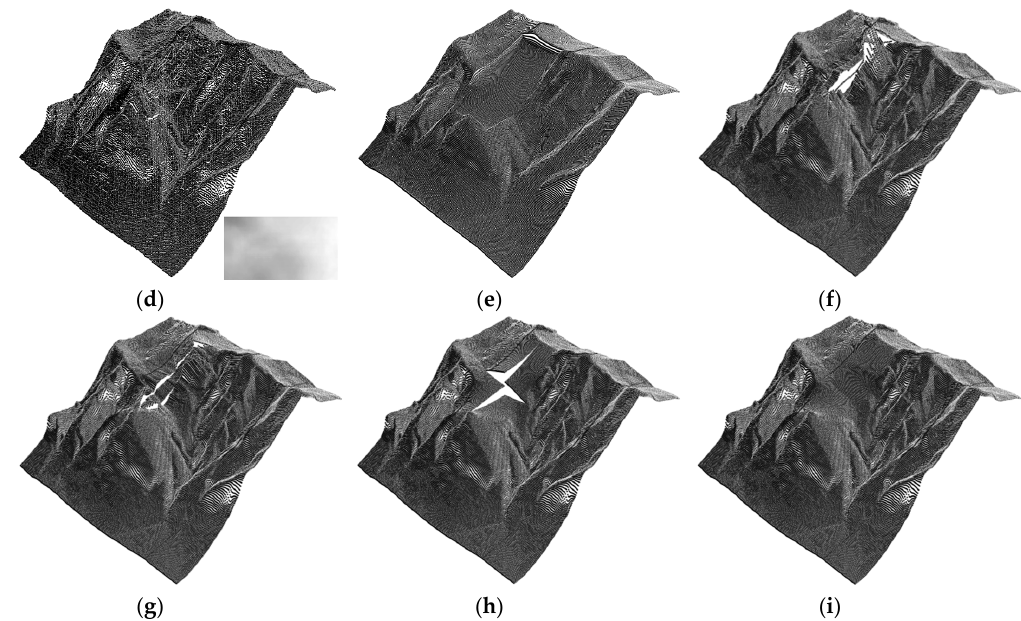
Figure 8. DEM 3D terrain filling results of a certain place in Sichuan province (complex terrain). ( a ) Raw DEM data; ( b ) DEM data with a void; ( c ) our method (the image in the lower right corner is a direct comparison of the results generated by the two methods); ( d ) WGAN method; ( e ) IDW method;